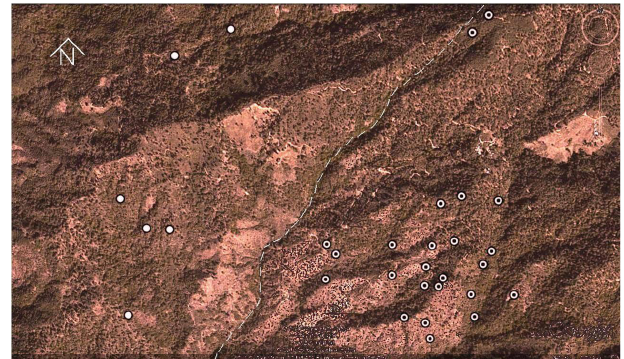
Fig 1. The spatial distribution of Melipona colimana wild nests in the study area. Every O mark indicates the position of a nest in the disturbed (D) area (n=6) and the ʘ mark indicates a nest in preserved (P) area